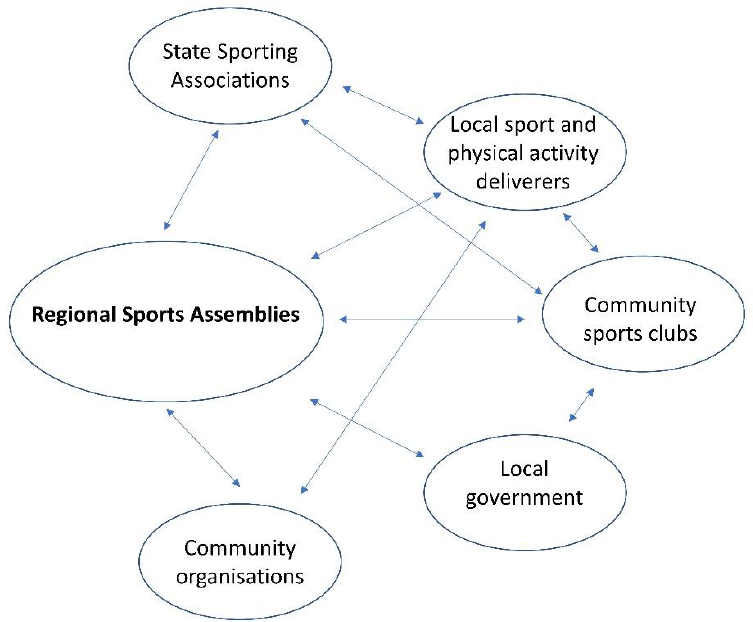
Figure 1. The network of organisations that partner to deliver the Regional Sport Program.